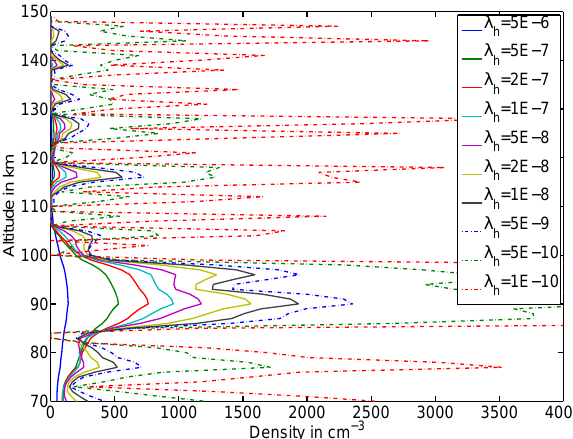
Fig. 25. Single day (7 September 2009) vertical profile for Mg (285.2nm) in the equatorial region from 15 ◦ S to 15 ◦ N. For too low constraint strength ( λ h < 5 × 10 − 9 ) the profile is strongly os- cillating, while for too high constraint strength ( λ h > 5 × 10 − 7 ) the profile is too smooth. Acceptable solutions between these two ex- trema show peak densities from 500 to 2000cm − 3 . However, at least the peak altitude is nearly independent of λ h . The solution with λ h = 5 × 10 − 8 is favored, considering, e.g., seasonal variations etc.